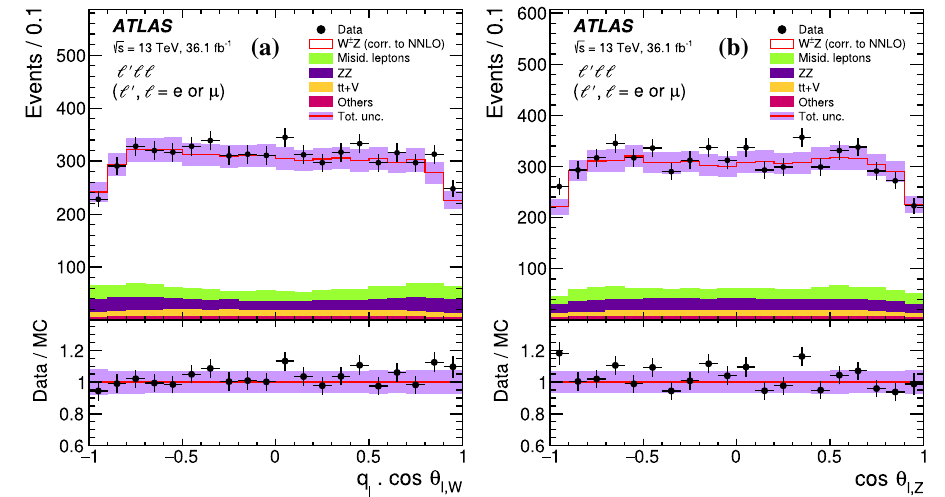
Fig. 9 The detector-level distributions for the sum of all channels of the variables a q (cid:4) · cos θ (cid:4), W and b cos θ (cid:4), Z . The points correspond to the data with the error bars representing the statistical uncertainties, and the histograms correspond to the predictions of the different SM processes. The sum of the background processes with misidentified lep- tons is labelled “Misid. leptons”. The Powheg+Pythia MC prediction